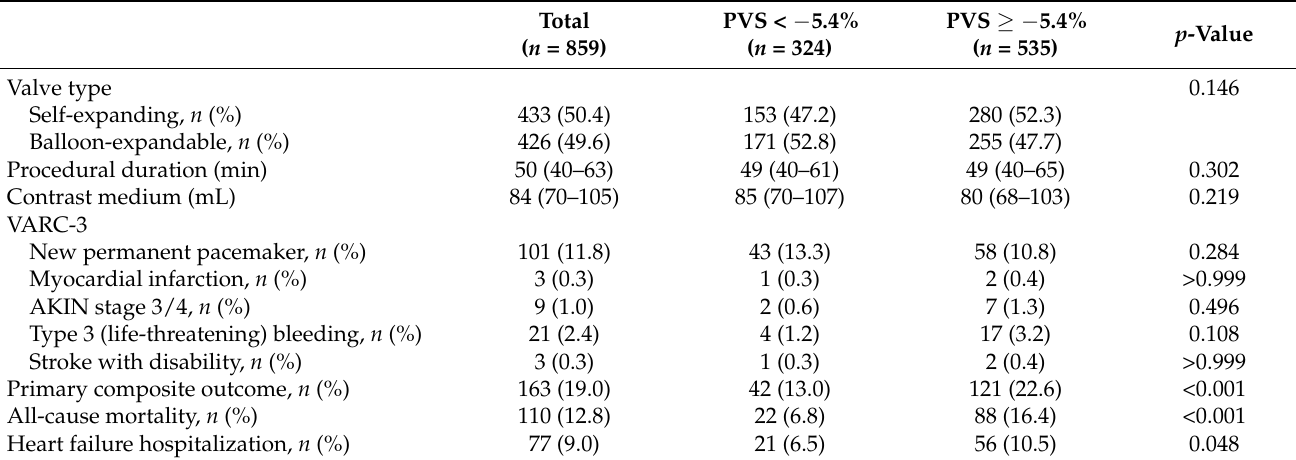
Table 2. Procedural variables and